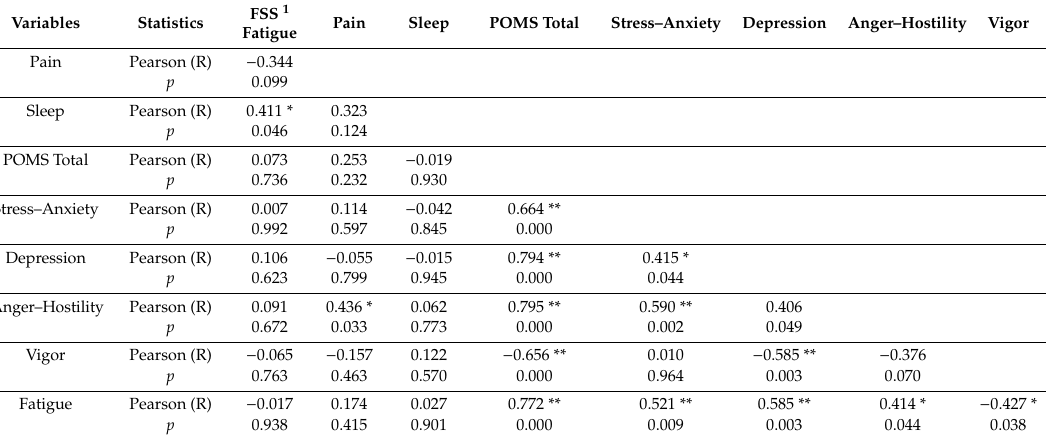
Figure 2. E ff ect of manual therapy. a: Di ff erences between pre- and post-intervention ( p < 0.001) for the pain scale; A: Di ff erences between Placebo and Manual therapy groups ( p = 0.044). Table 3. Correlations between variables increments